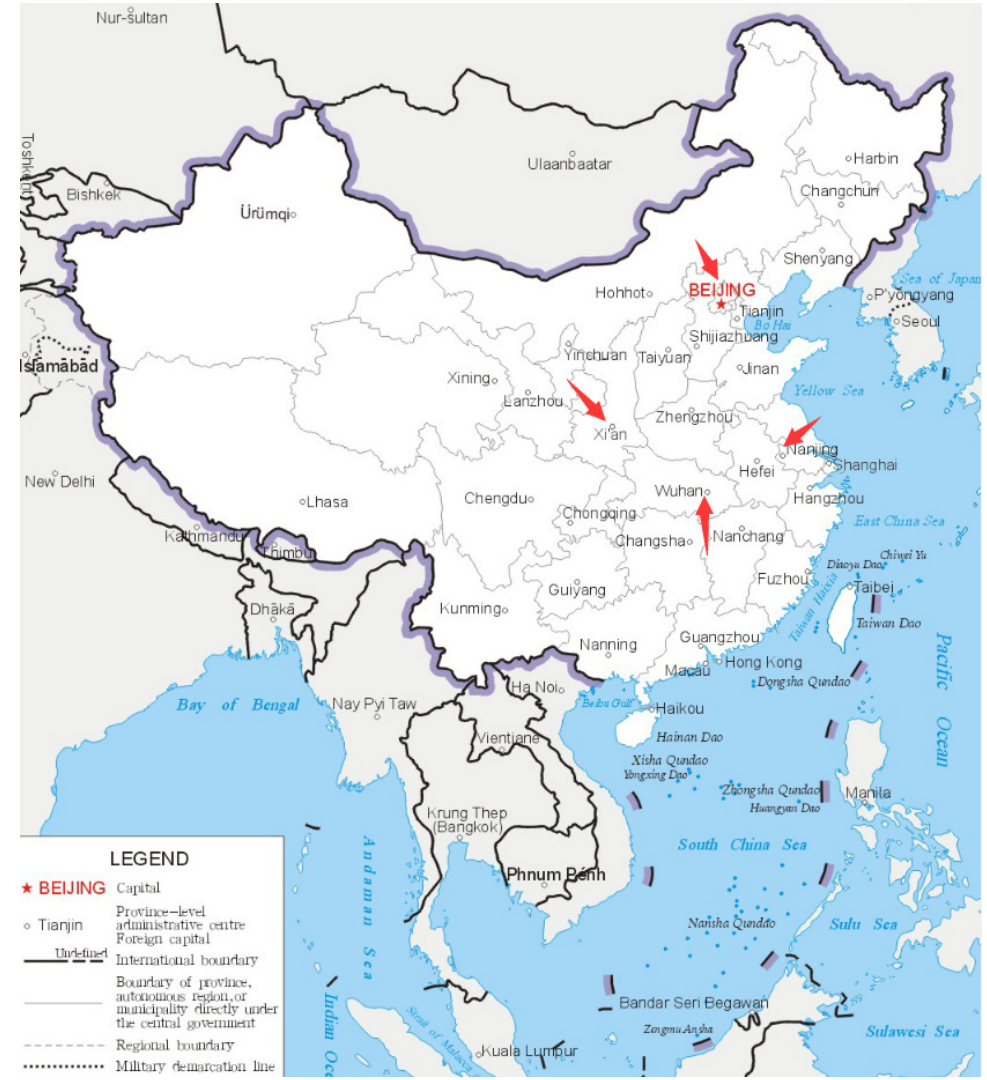
Figure 1. The four cities constituting the study areas: Wuhan, Nanjing, Beijing, and Xi’an.